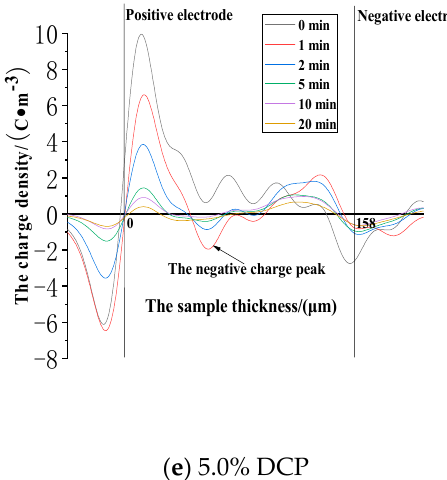
Figure 8. The space charge distribution when each sample experiences de-voltage after the action of 50 kV / mm. ( a ) The experimental results of the pure LDPE samples. ( b ) The experimental results of the samples with 1.0% DCP. ( c ) The experimental results of the samples with 2.1% DCP. ( d ) The experimental results of the samples with 3.0% DCP. ( e ) The experimental results of the samples with 5.0% DCP.